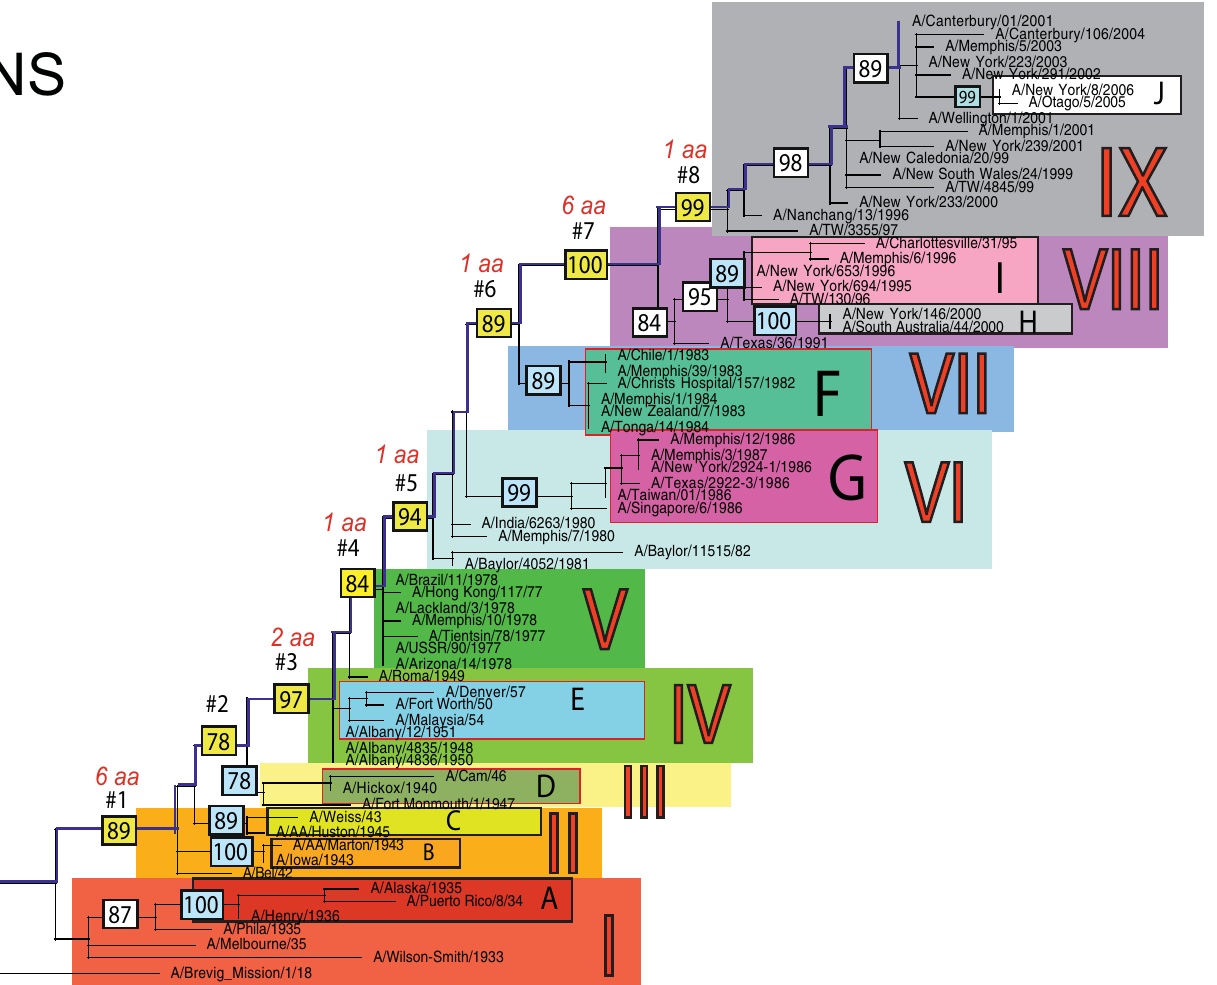
Figure 8. Phylogenetic relationships of the NS1 gene of A/H1N1 influenza viruses (n=71) sampled globally from 1918–2006, estimated using ML. Rooting, scale, and color scheme are the same as those used in Figure 1.